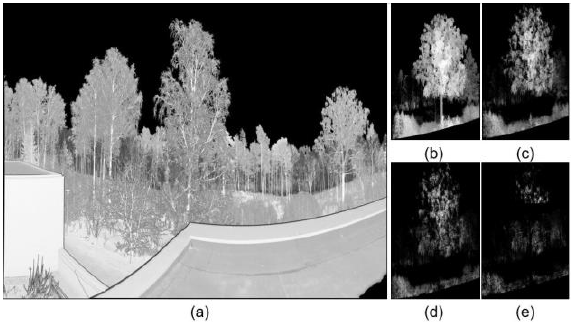
Figure 4. Example of raster images, in which (a) show a reflectance image of the whole scanned scene. (b) - (e)